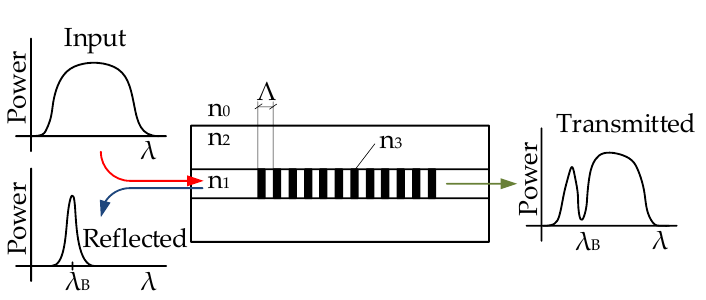
Figure 1. Principle of fiber optic Bragg